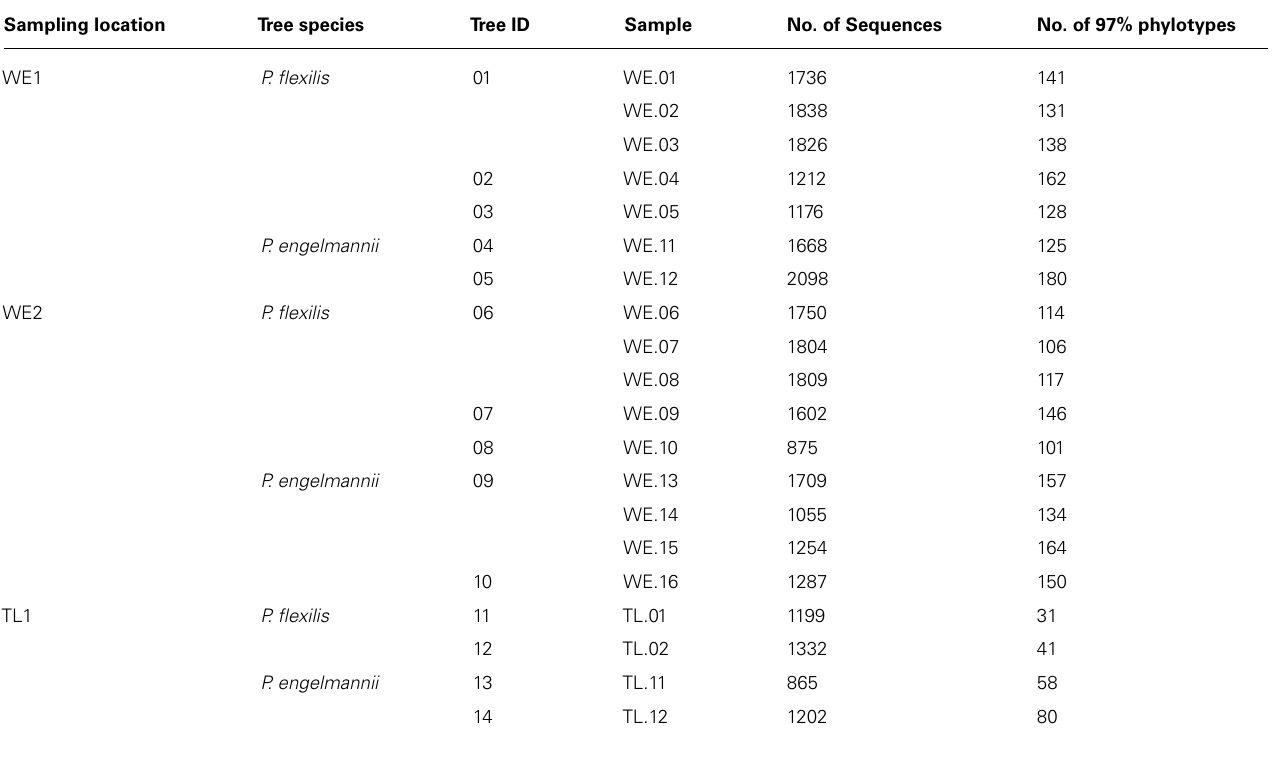
Table 1 | Samples successfully characterized by 16S rRNA in this study, along with the number of sequences after sequence quality control and removal of plant DNA. Sampling